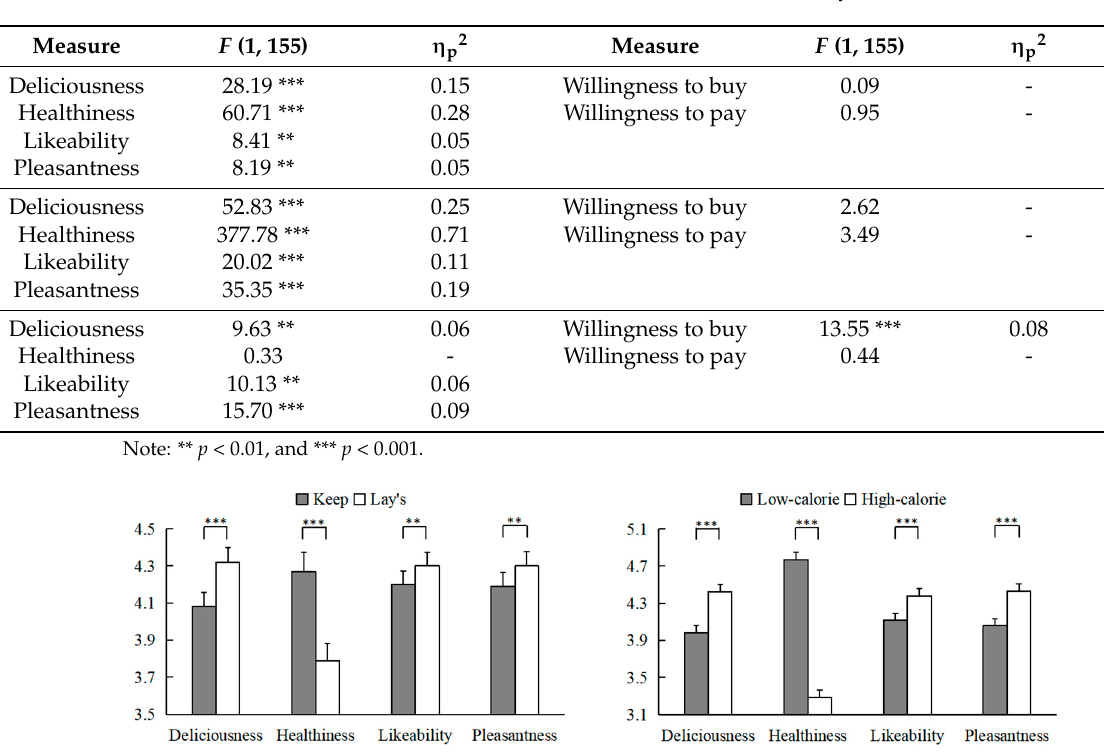
Figure 1. The mean scores of subjective ratings and purchase intention in Study 1. Error bars show the standard errors of the means. Table 1. The results of ANOVAs conducted on the data collected in Study 1.